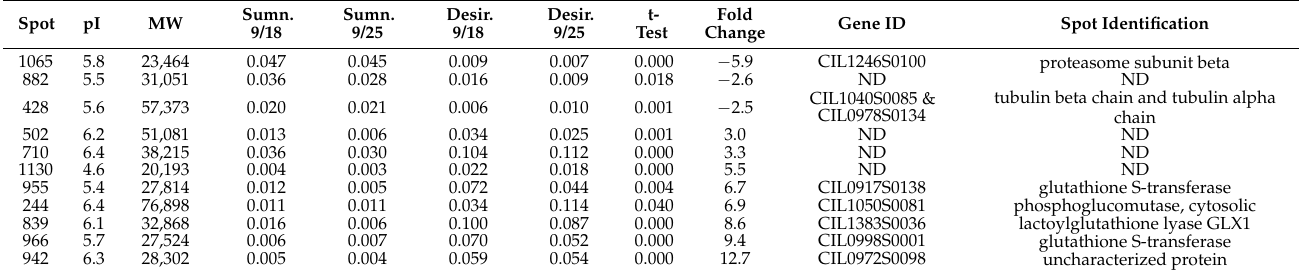
Table 2. Pecan nut proteins with relative accumulation differences between cultivars. Protein spots with differential relative accumulation between cultivars as quantified by 2-D electrophoresis are listed by spot identification number, isoelectic point, and molecular weight. Mean spot percentages for the two cultivars are listed by time point. The t-test and fold change compare spot percentages of both time points together. Spots listed have at least a two-fold change between the average Sumner pecan nut and the average Desirable pecan nut, both collectively ( n = 4) and for both developmental stages individually ( n = 2). All spots listed have at least one sample in which the spot percentage is at least one-fourth the overall average of spot intensity. Gene IDs for identified proteins are as described in Huang et al.